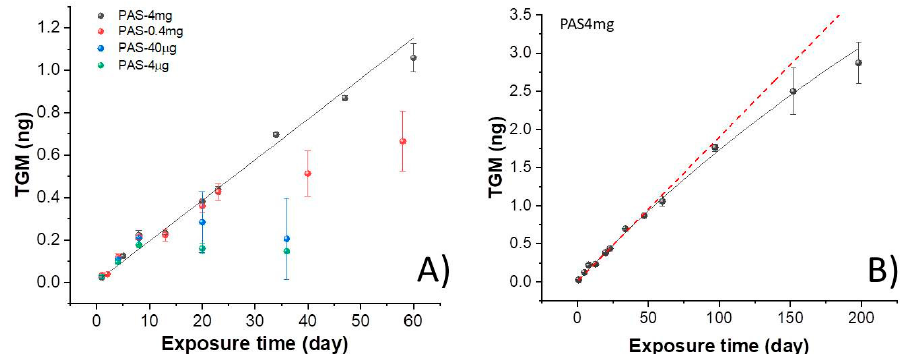
Figure 5. ( A ) Uptake curves (adsorbed mercury versus exposure time) of PAS4mg, PAS-0.4mg, PAS40 µ g and PAS4 µ g samples. Vertical bars correspond to standard deviation and dark gray line to linear fit of the PAS-4mg values (R 2 = 0.995). ( B ) A non-linear fitting of PAS4mg curve within an exposure time of 198 days compared to a linear fitting (the red dotted line).